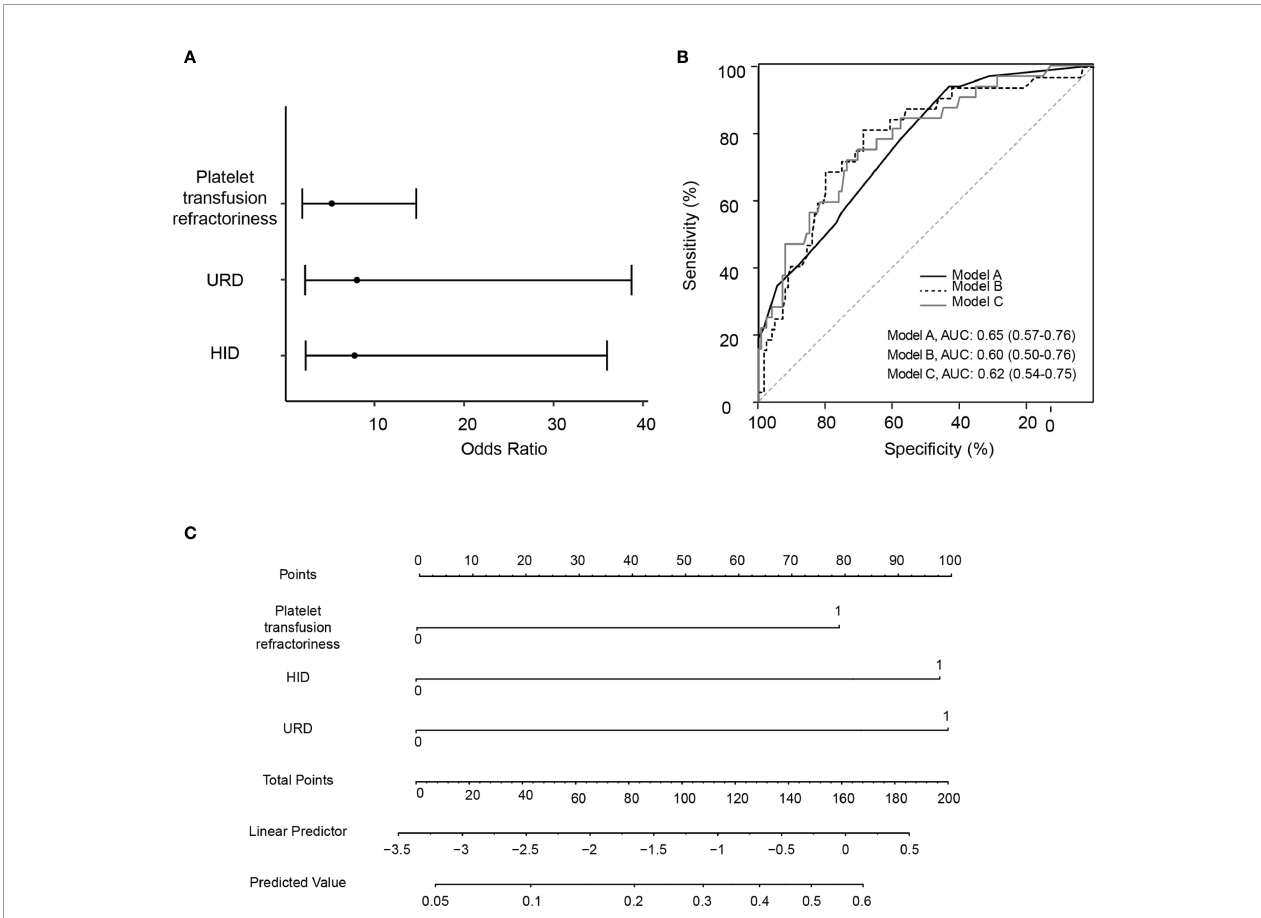
FIGURE 2 | Construction and validation for the logistic regression models for pre-transplant variables and risk of cytomegalovirus retinitis. (A) A forest plot of odds ratio values with 95% con fi dence intervals in logistic regression model A. (B) Area under the receiver operating characteristic curve (AUC) for Model A, Model B (adjusted by age and gender), and Model C (adjusted by age, gender and diagnosis). (C) The nomogram for evaluating the risk for cytomegalovirus retinitis, with the rows ranging from 2 to 4 representing the included variables. The risk for cytomegalovirus retinitis among severe aplastic anemia recipients was estimated by plotting on each variable axis. A vertical line was drawn from that value to the top points scale to determine the number of points that were assigned by that variable value. The points from each variable value were then summed. The sum on the total points scale was located and vertically projected onto the bottom axis, and then the predicted value of risk for cytomegalovirus retinitis was obtained. URD, unrelated donor; HID, haploidentical donor; AUC, area under the receiver operating characteristic